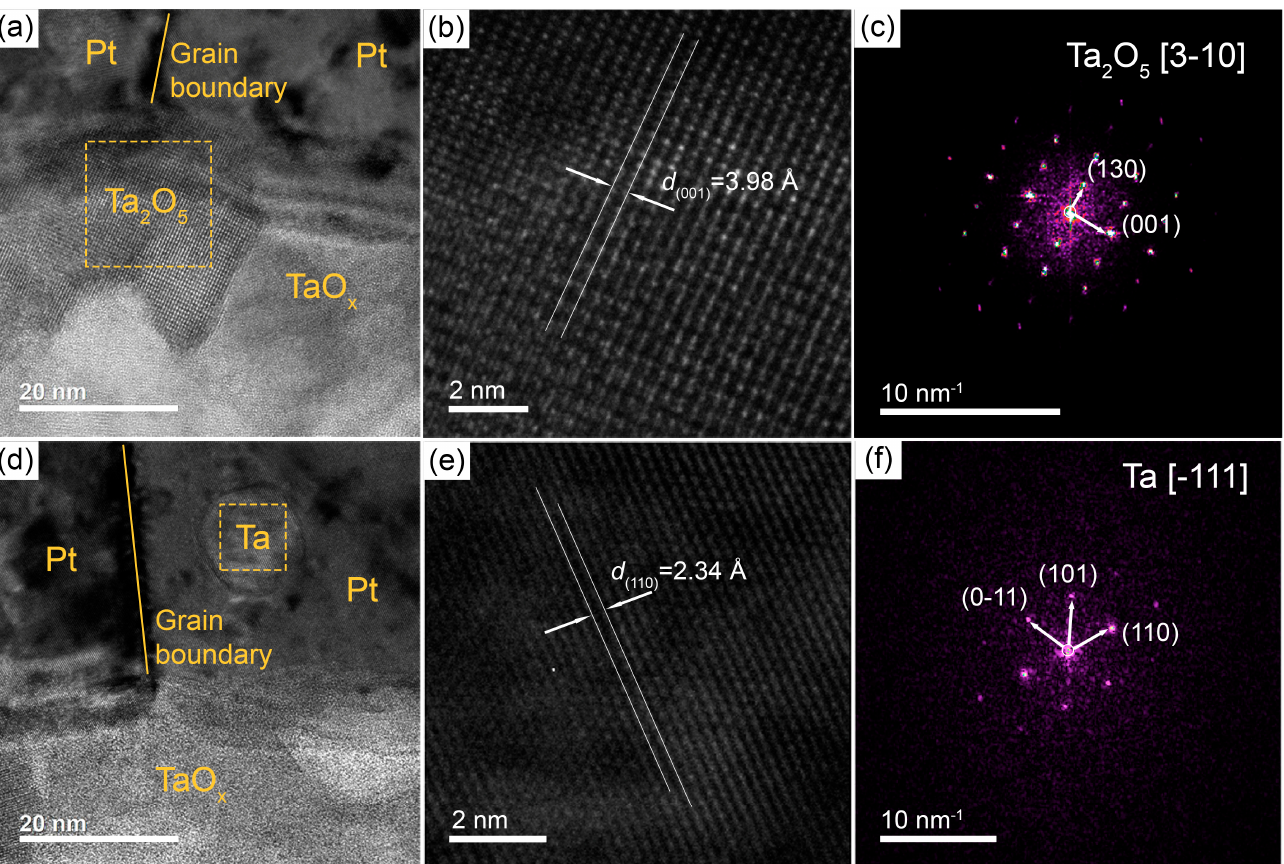
Figure 4. Cross-sectional high-resolution transmission electron microscopy (HRTEM) images of the Ta/Pt film annealed at 730 °C for 12 h ( a , d ) with zoomed images showing lattice structure of boxed area ( b , e ) and corresponding FFT patterns ( c , f ).